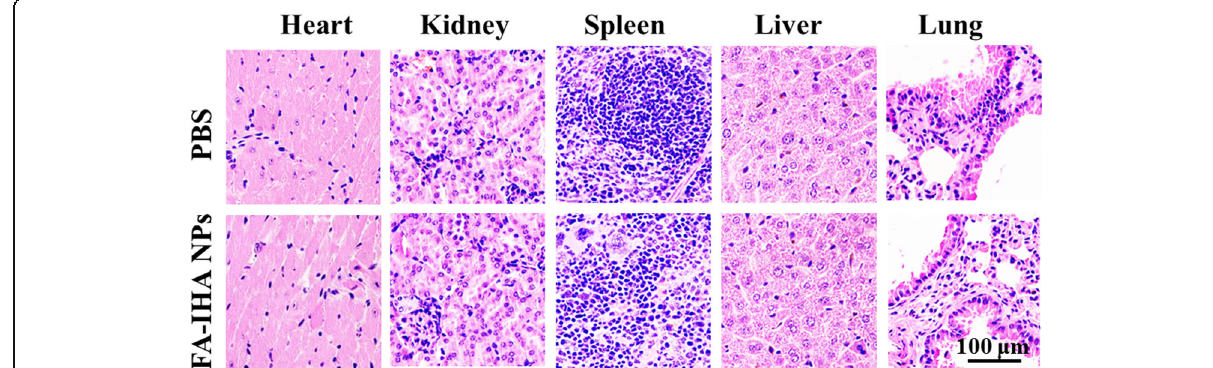
Fig. 10 H&E-stained tissue sections of major organs, including heart, liver, spleen, lungs, and kidney from mice treated with PBS and FA-IHA